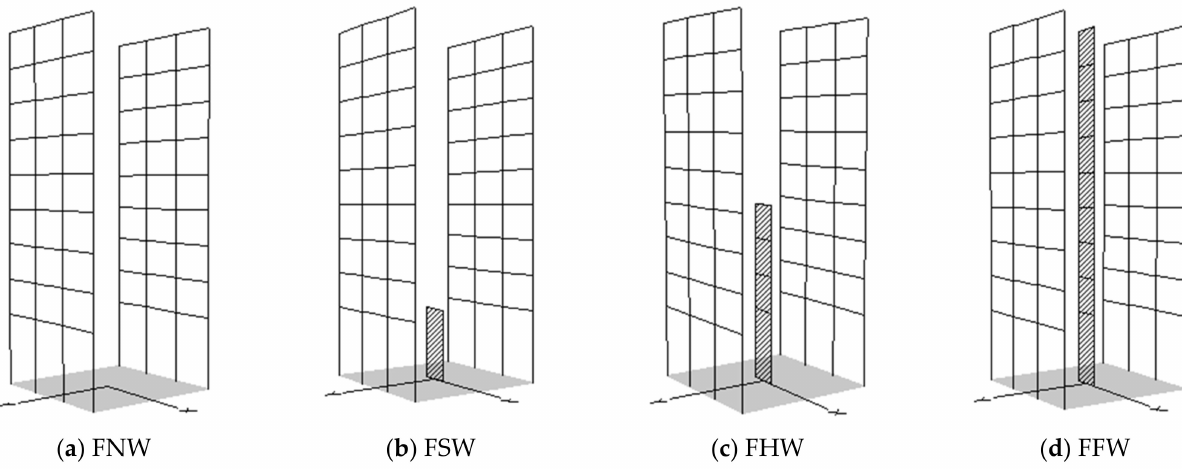
Figure 10. STERA_3D models of test